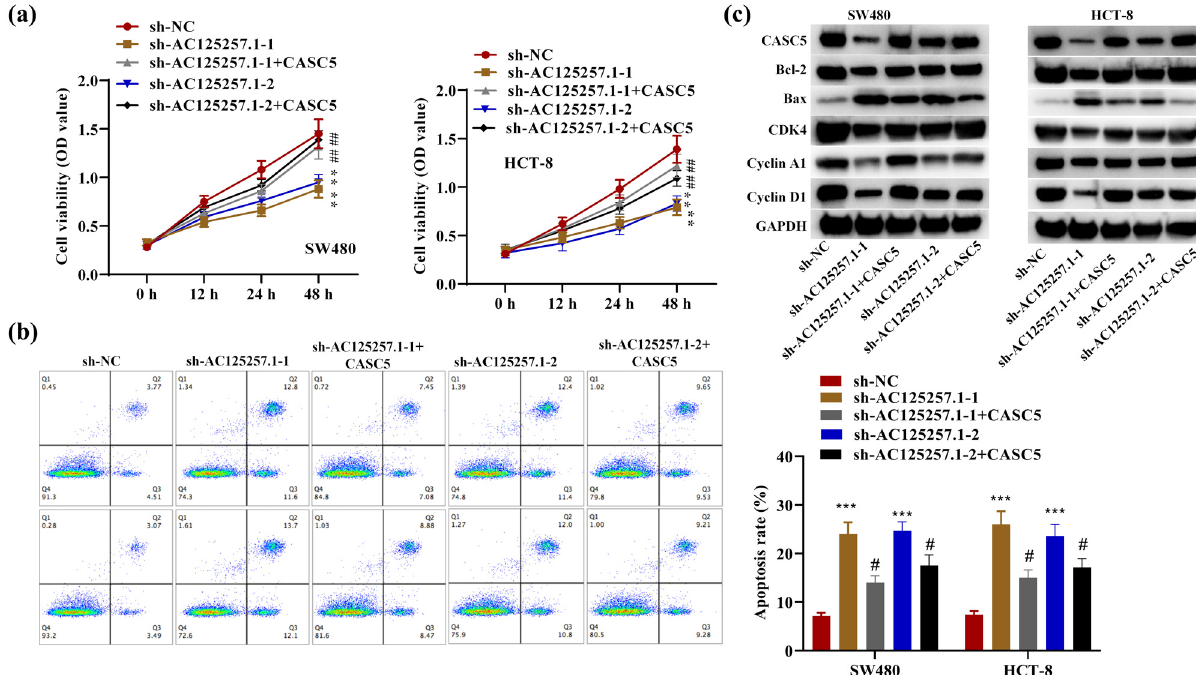
Figure 5: ( a ) OD value of 450nm in SW480 - and HCT - 8 - transfected with sh - NC, sh - AC125257.1, and sh - AC125257.1 + CACS5 at 0, 12, 24, and 48h. ( b ) Flow cytometry results and apoptosis rate of SW480 and HCT - 8 transfected with sh - NC, sh - AC125257.1, and sh - AC125257.1 + CACS5. ( c ) WB results of CASC5, Bcl - 2, Bax, CDK4, Cyclin A1, Cyclin D1, and GAPDH in SW480 - and HCT - 8 - transfected with sh - NC, sh - AC125257.1, and sh -